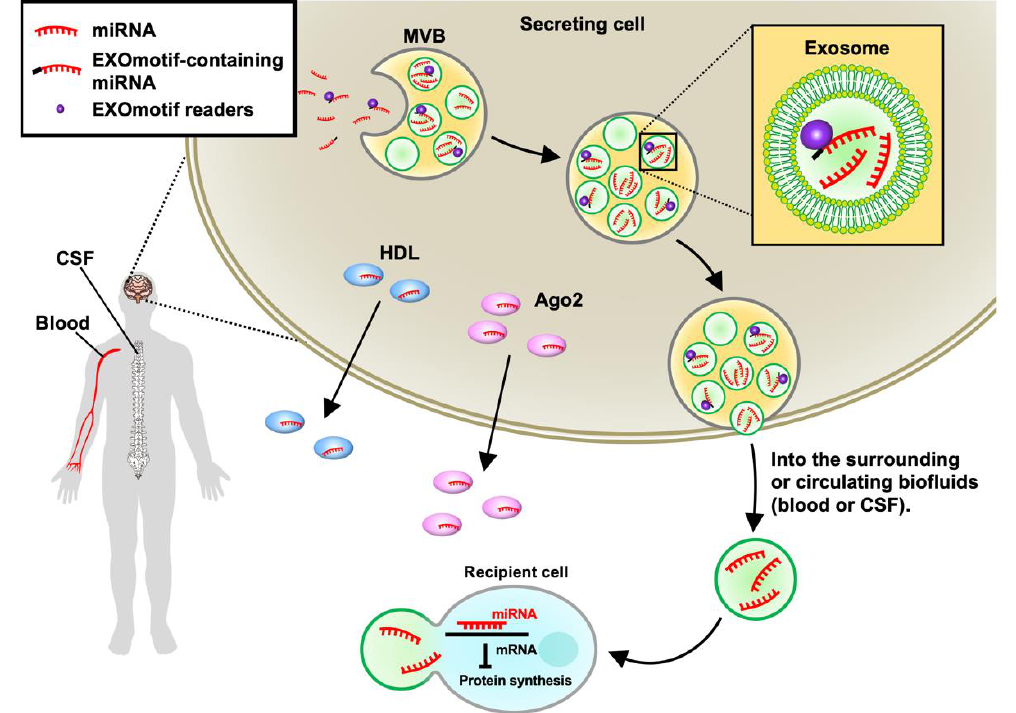
Figure 2. MicroRNA (miRNA) sorting. After miRNA biogenesis, mature miRNAs bound by Argonaute 2 (Ago2) or high-density lipoprotein (HDL) can be transported extracellularly. Some miRNAs can be secreted by the means of exosomes, which are formed within multivesicular bodies (MVBs) in the cytoplasm. EXOmotif readers, such as hnRNPA2B1 and FUS, bind to specific sequences (EXOmotif) existing in miRNAs and facilitate the loading of EXOmotif-containing miRNAs into exosomes. When MVBs fuse with the plasma membrane, exosomes are released into the extracellular space surrounding the secreting cell and eventually enter the circulating biofluids, such as the blood and cerebrospinal fluid (CSF). The recipient cell uptakes these miRNA-containing exosomes, resulting in the alteration of their gene expression profile. The extracellular miRNAs, including miRNAs bound by proteins or encapsulated in exosomes, in the blood, and CSF can be detected as biomarkers for neurodegenerative diseases (NDs).